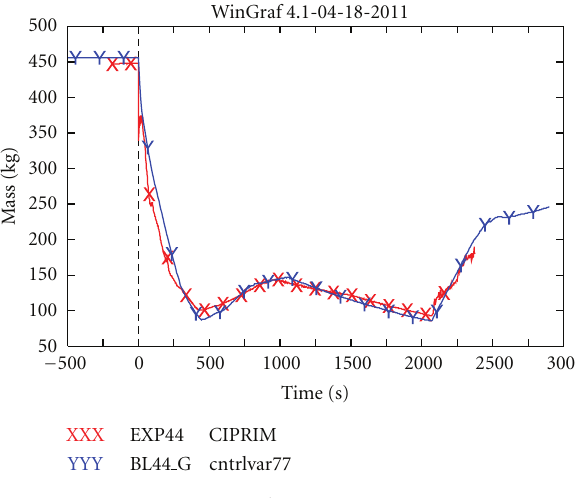
Figure 15: Primary system mass.